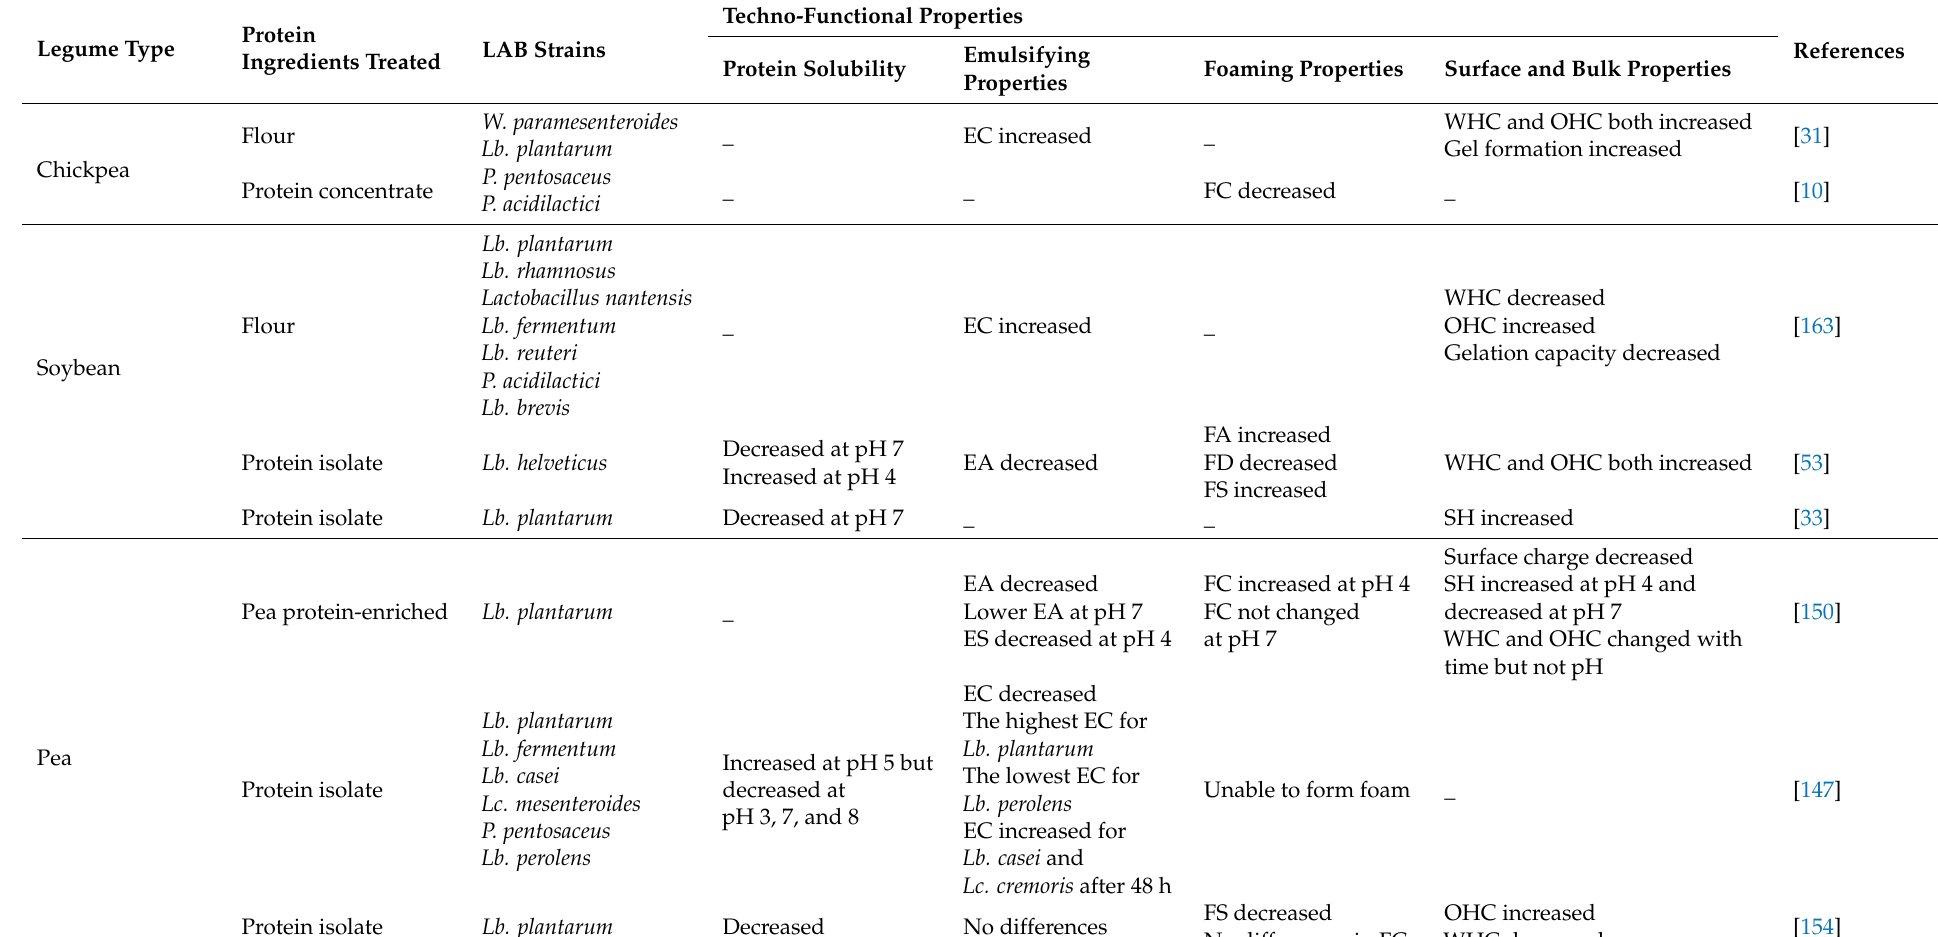
Table 2. The effects of lactic acid fermentation on techno-functional properties of legume